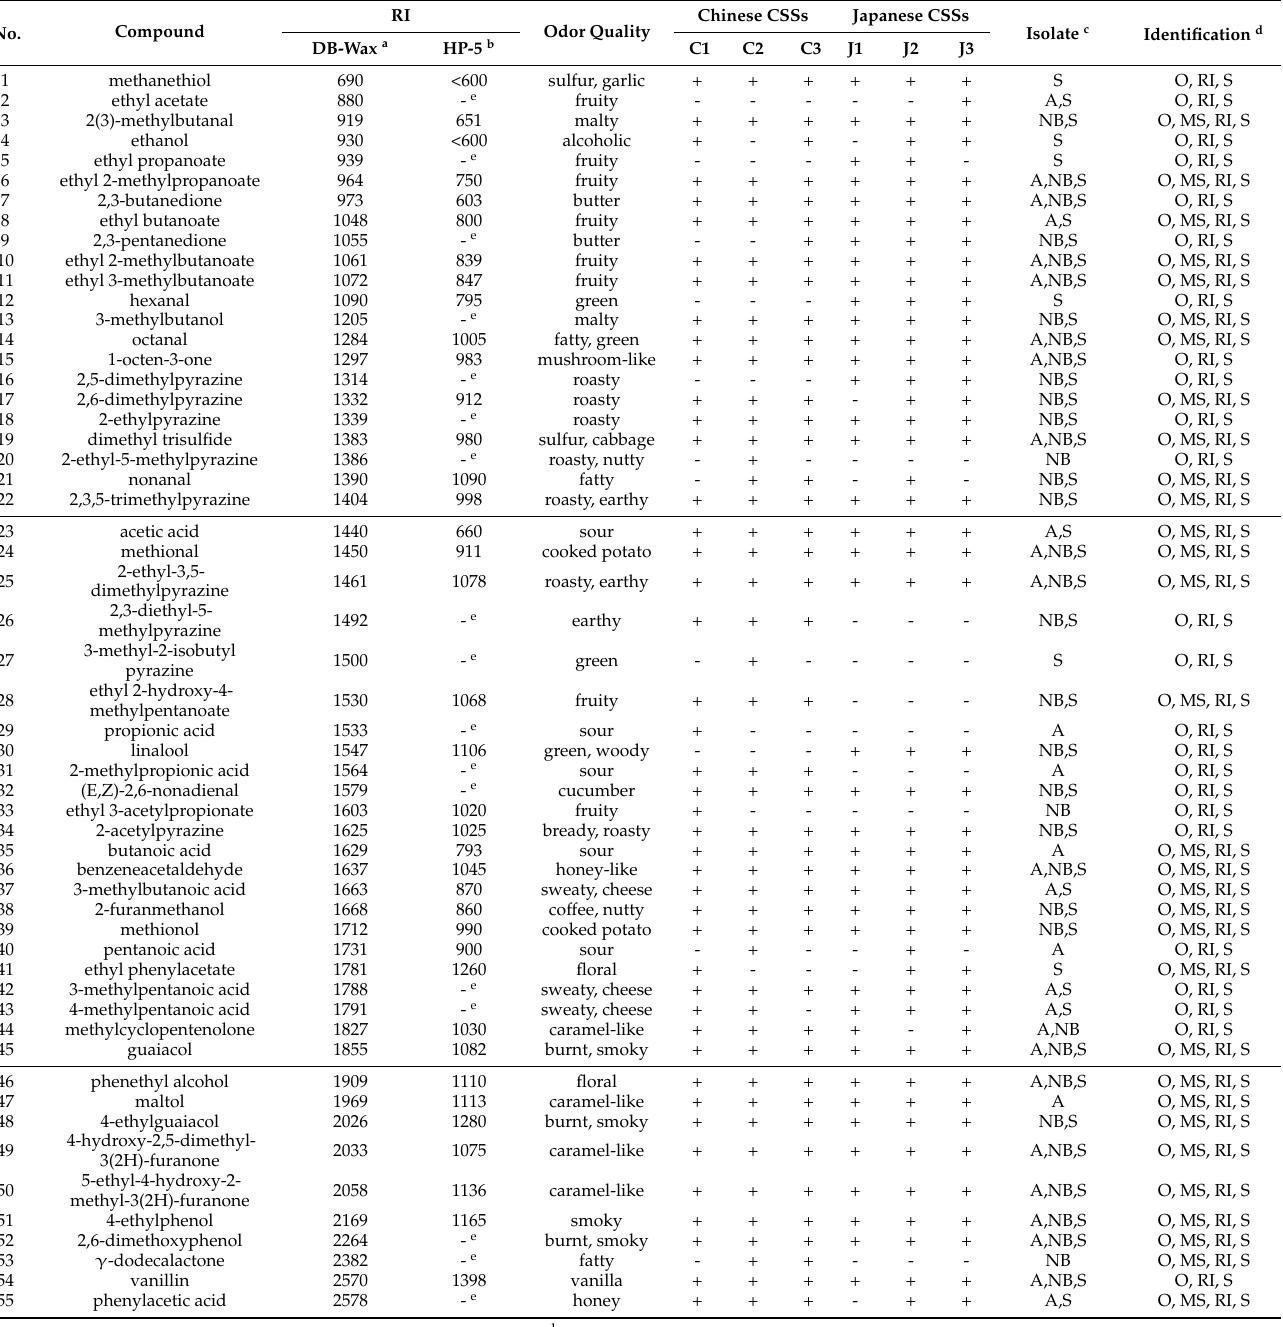
Table 1. Odor-active compounds identified in six CSS